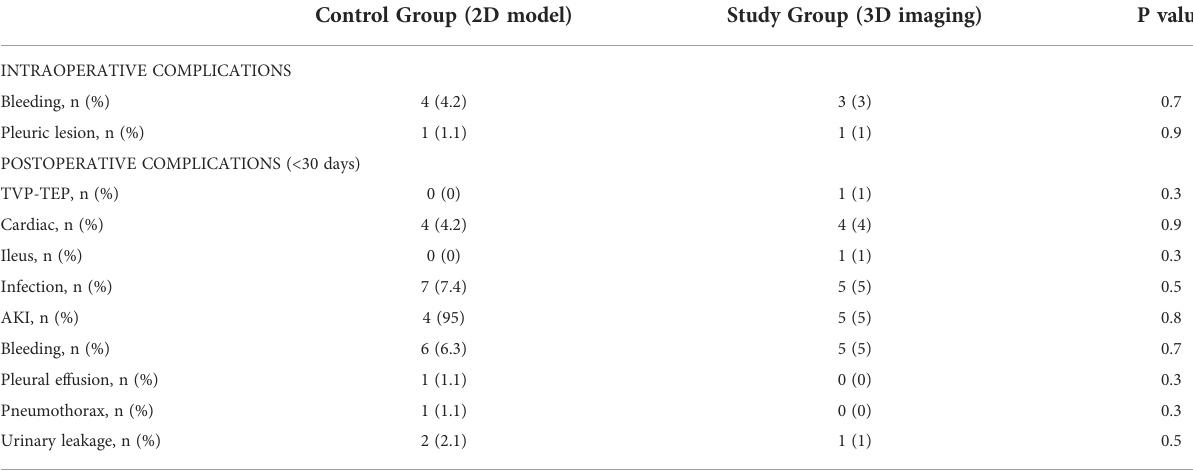
TABLE 4 Intraoperative and postoperative complications in the overall population (n=195).